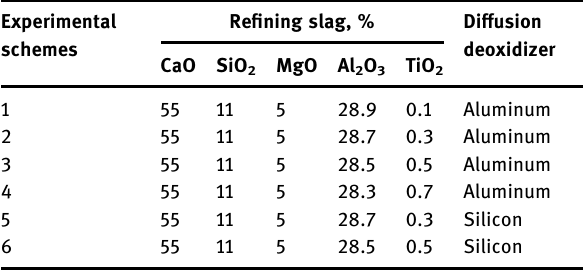
Table 5: Experiment schemes Experimental